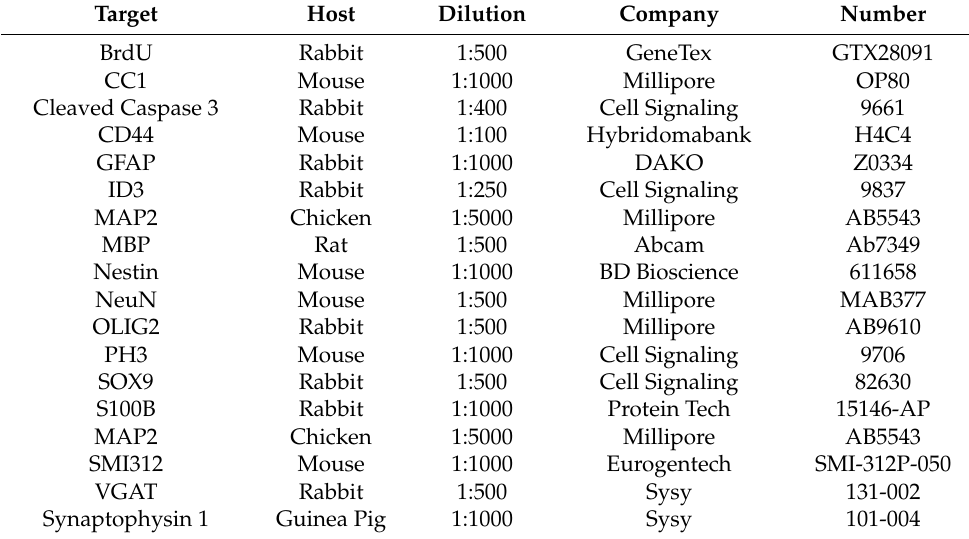
Table 2. Primary